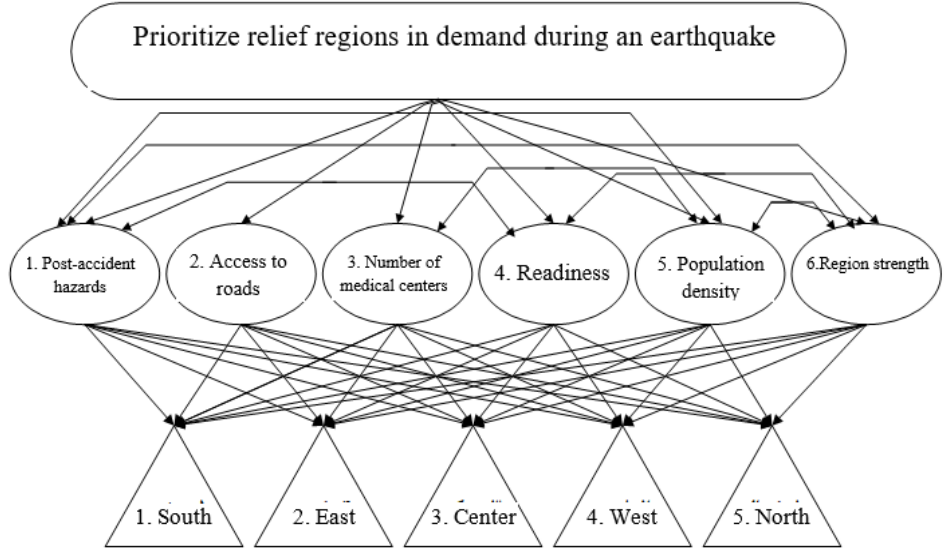
Fig. 2. Internal and external dependence of demand point prioritization